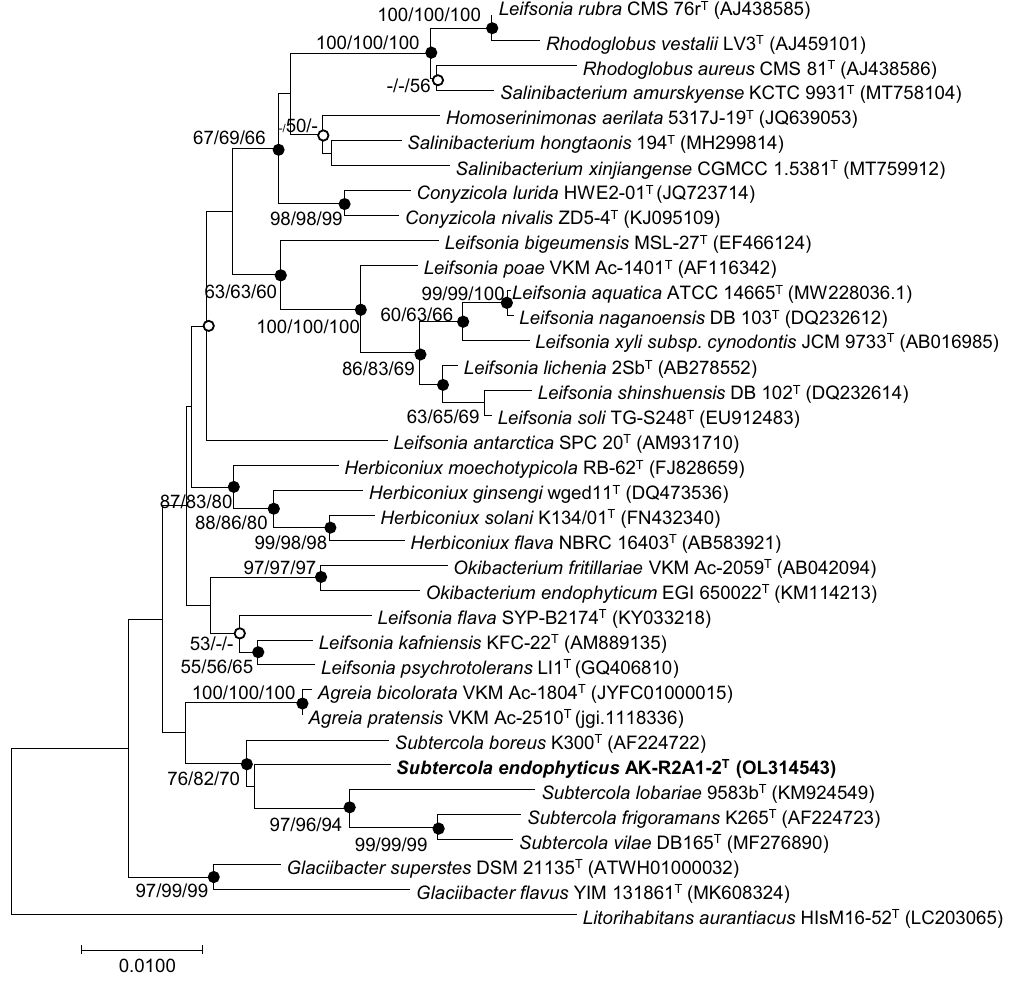
Figure 1. Neighbor-joining (NJ) phylogenetic tree based on 16S rRNA gene sequences showing the position of strain AK-R2A1-2 T . Bootstrap values (> 50%) were calculated using the NJ, maximum-likelihood (ML), and minimum evolution (ME) algorithms. Filled circles on the nodes indicate that the relationships were also identified using the ML and ME algorithms, whereas open circles indicate nodes were identified by either the ML or the ME algorithm. Scale bar: 0.0100 substitutions per nucleotide